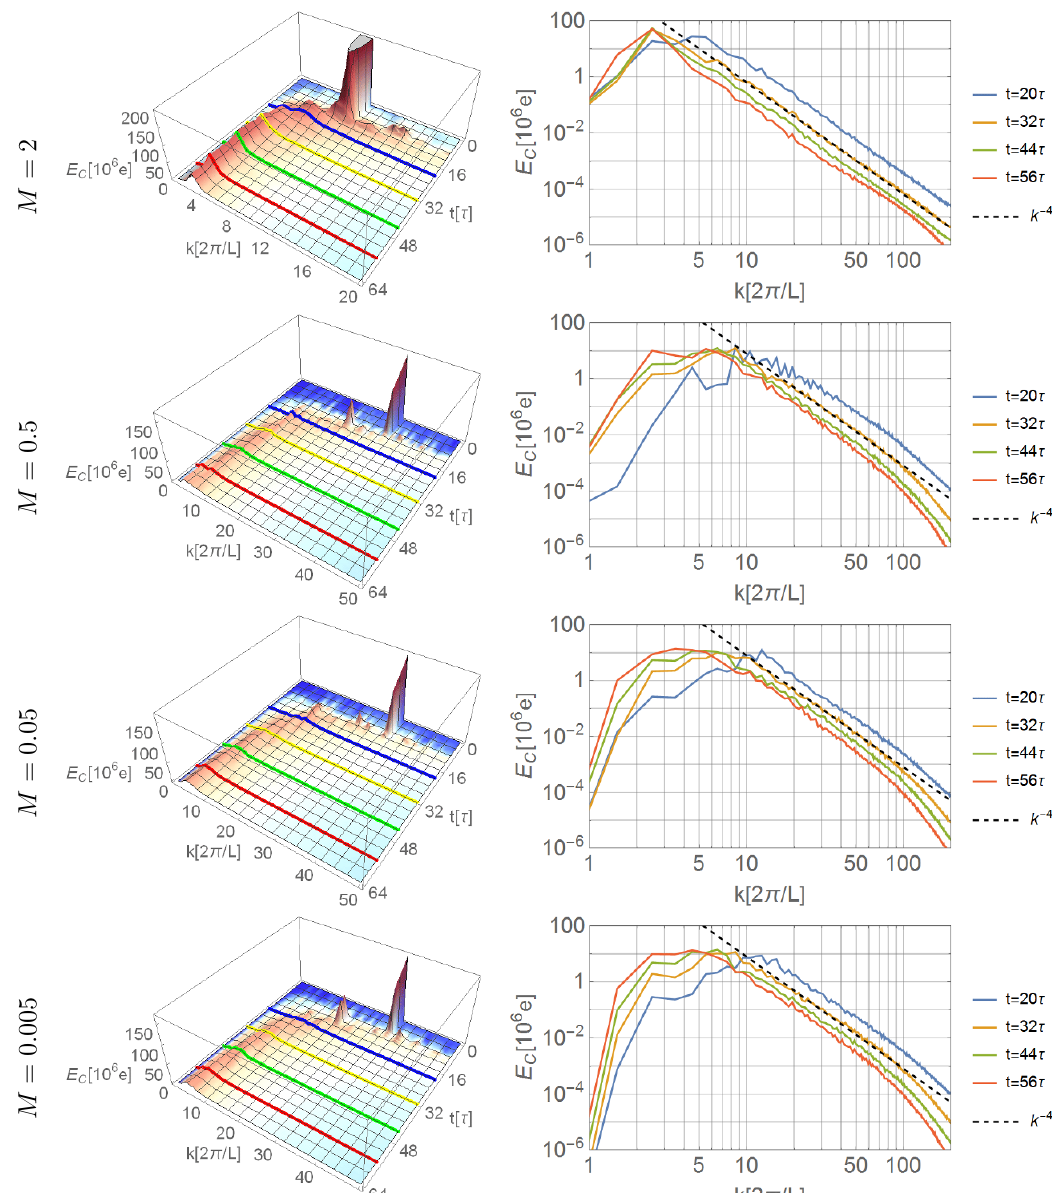
Figure 14 . The energy spectrum of two dimensional (cid:13)ow with an initial Reynolds number of Re = 1562 : 5 for di(cid:11)erent initial Mach numbers. The right column provides detailed information on the power spectrum for four selected